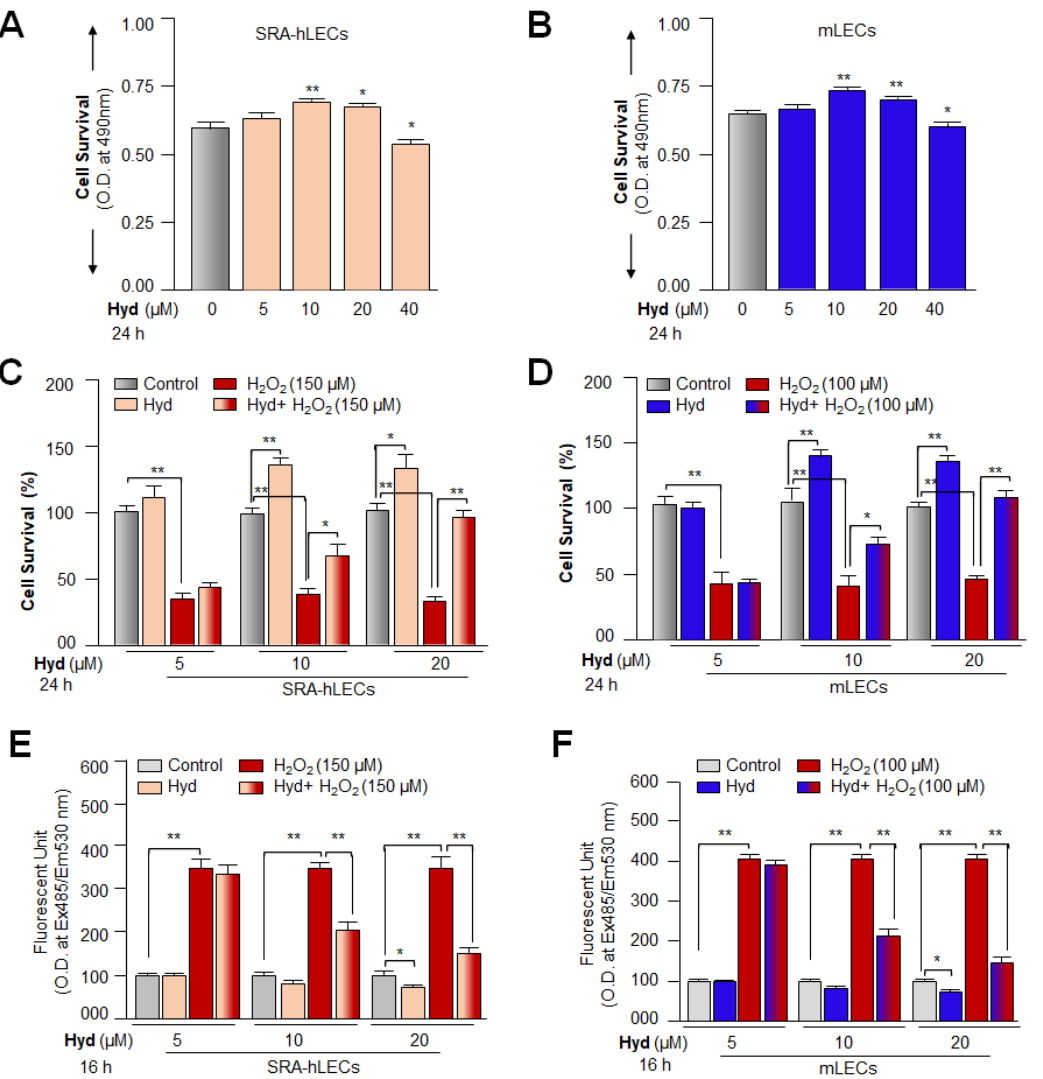
Figure 1. Hyd protects LECs from H 2 O 2 -induced oxidative cell death. ( A , B ) Viability assay showing the dose-dependent effect(s) of Hyd on survival of SRA-hLECs and mLECs. Cultured SRA-hLECs and mLECs were treated with different concentrations of Hyd to determine its nontoxic concentration using MTS assay. The data represent the mean ± S.D. of three independent experiments. Untreated vs. Hyd-treated LECs; * p < 0.05; ** p < 0.001. ( C , D ) The cell viability of LECs under H 2 O 2 -induced oxidative stress was significantly improved with Hyd treatment. Cultured SRA-hLECs and mLECs were exposed to H 2 O 2 in absence or presence of Hyd for 24 h as indicated in Figure 1, and cell viability was performed using MTS assay. Histograms represent the mean ± S.D. value of three independent experiments. * p < 0.05; ** p < 0.001. ( E , F ) Hyd defends LECs against H 2 O 2 -induced cell death by reducing the ROS levels. Hyd-treated and untreated SRA-hLECs and mLECs were exposed to H 2 O 2 . Then, 16 h later, ROS levels were quantified with H 2 -DCF-DA dye method. Histogram represents the mean ± S.D. of three independent experiments. * p < 0.05; ** p < 0.001. Peroxidation and Rescued Oxidative Protein and DNA After confirming that Hyd protects LECs by mitigating ROS accumulation and con- sidering the impact of oxidative-induced generation of toxic products-mediated aberrant modifications of proteins and DNA damage, we tested whether the Hyd halts oxidative DNA damage or attenuates the levels of oxidative stress-induced formation of toxic adducts, such as MDA (malondialdehyde)/4-HNE (4-hydroxyalkenals) or protein